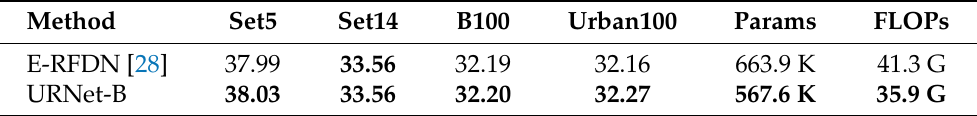
Table 3. The comparison of different fusion strategies (the step-by-step and Concat the features of all blocks). URNet-B achieves the best PSNR (dB) scores on the four benchmark datasets ( × 2 SR).